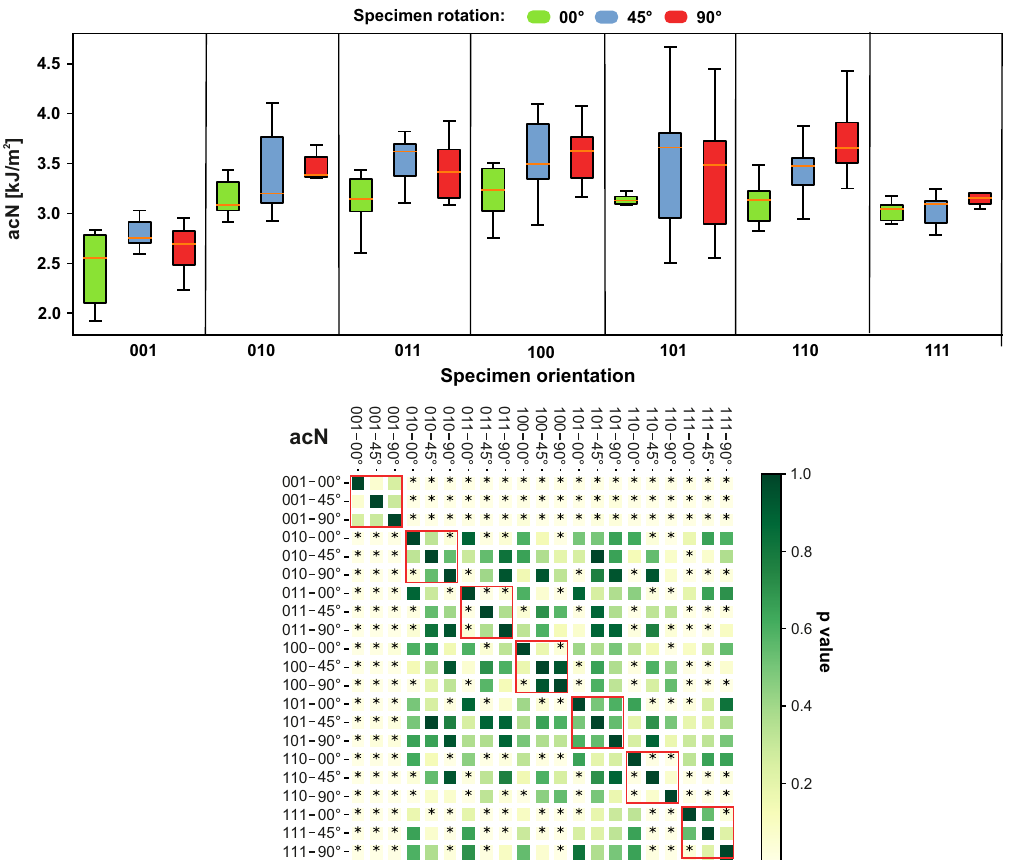
Figure 11. Impact of different sample orientations on the impact strength acN. The red border in heatmap highlights specimens with equal orientation. The members marked as * express a statistically significant